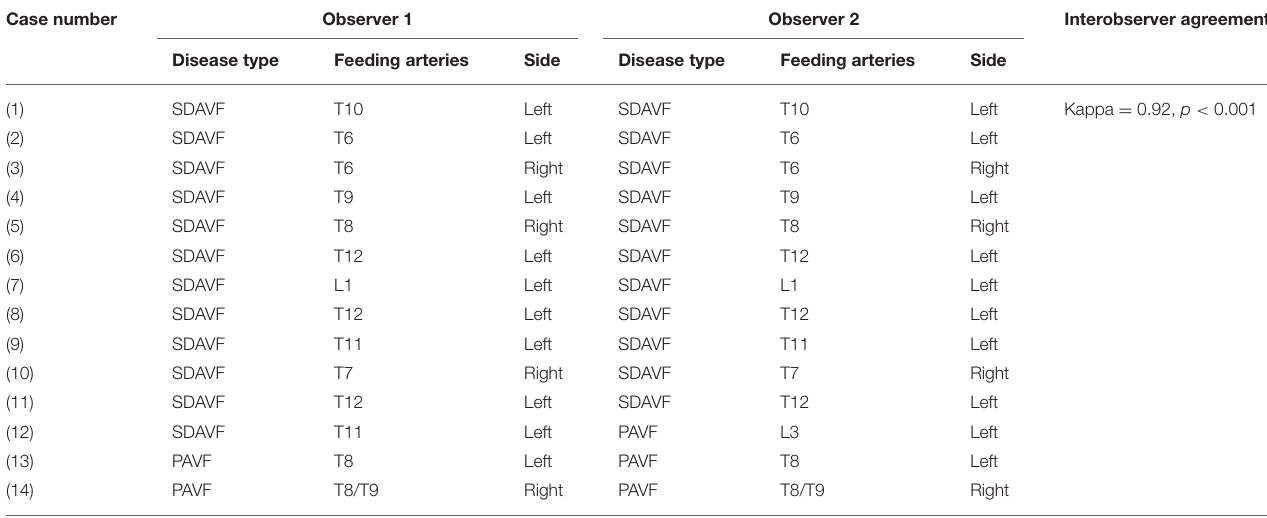
TABLE 3 | The interobserver agreement of the spinal cord vascular malformations on time-resolved angiography with stochastic trajectories between two observers. Case number